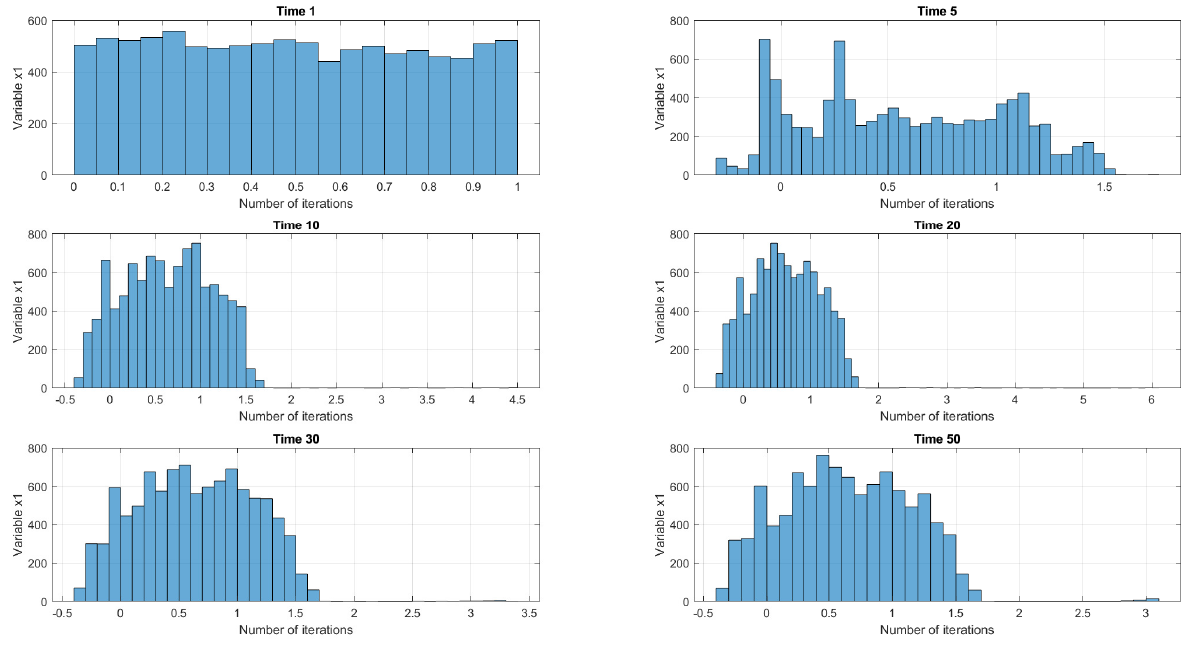
Figure 9. Transient time—Ikeda map—histograms for variable x 1